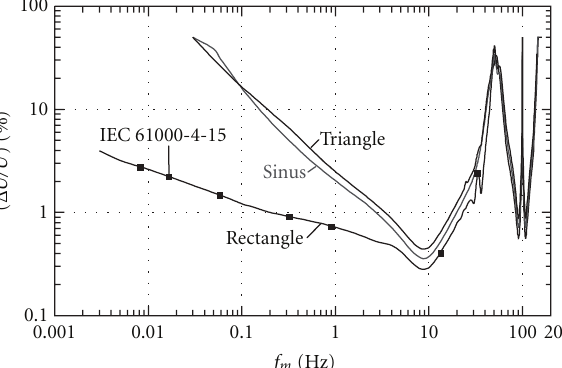
Figure 6: Plot of ( Δ U/U ) = f ( f m ) dependence for rectangular, sinusoidal and triangular modulating signals with P st = 1 = const; black dots—Table 5 from